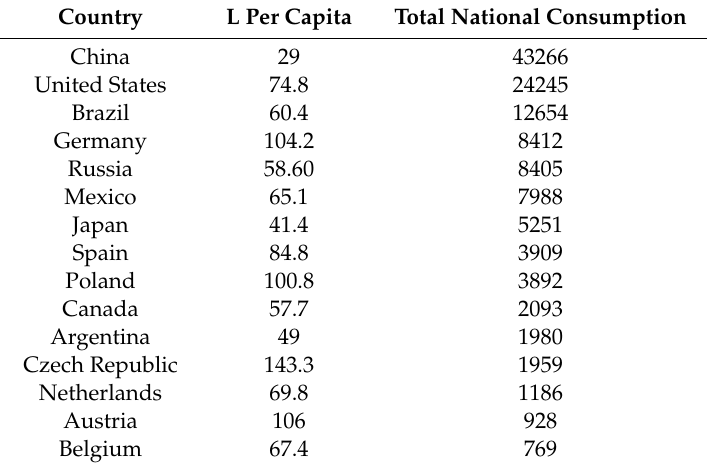
Table 1. Beer consumption in di ff erent